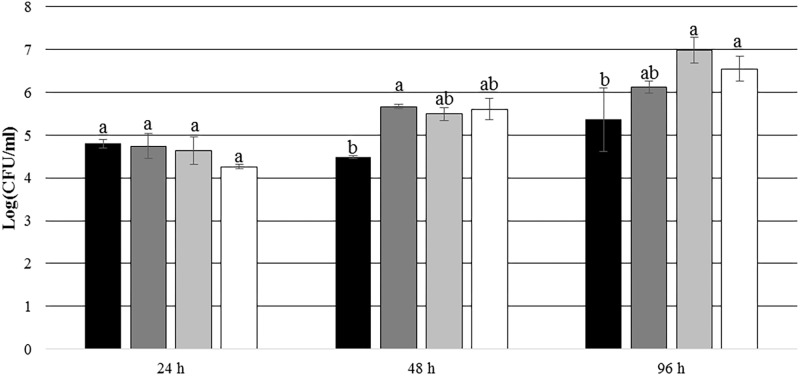
Number of attached P. inhibens ΔtdaB from 24 to 96 h with either E. huxleyi or f/2 medium inside the chamber. Grouping based on ANOVA post hoc Tukey test. Groups within each sampling time that do not share a letter are significantly different (24 h: P = 0.068; 48 h: P = 0.024; 96 h: P = 0.010).
P. inhibens
ΔtdaB with E. huxleyi, experimental membranes;
P. inhibens
ΔtdaB with E. huxleyi, blinded membranes;
P. inhibens
ΔtdaB with f/2 medium, experimental membranes;
P. inhibens
ΔtdaB with f/2 medium, control membranes.